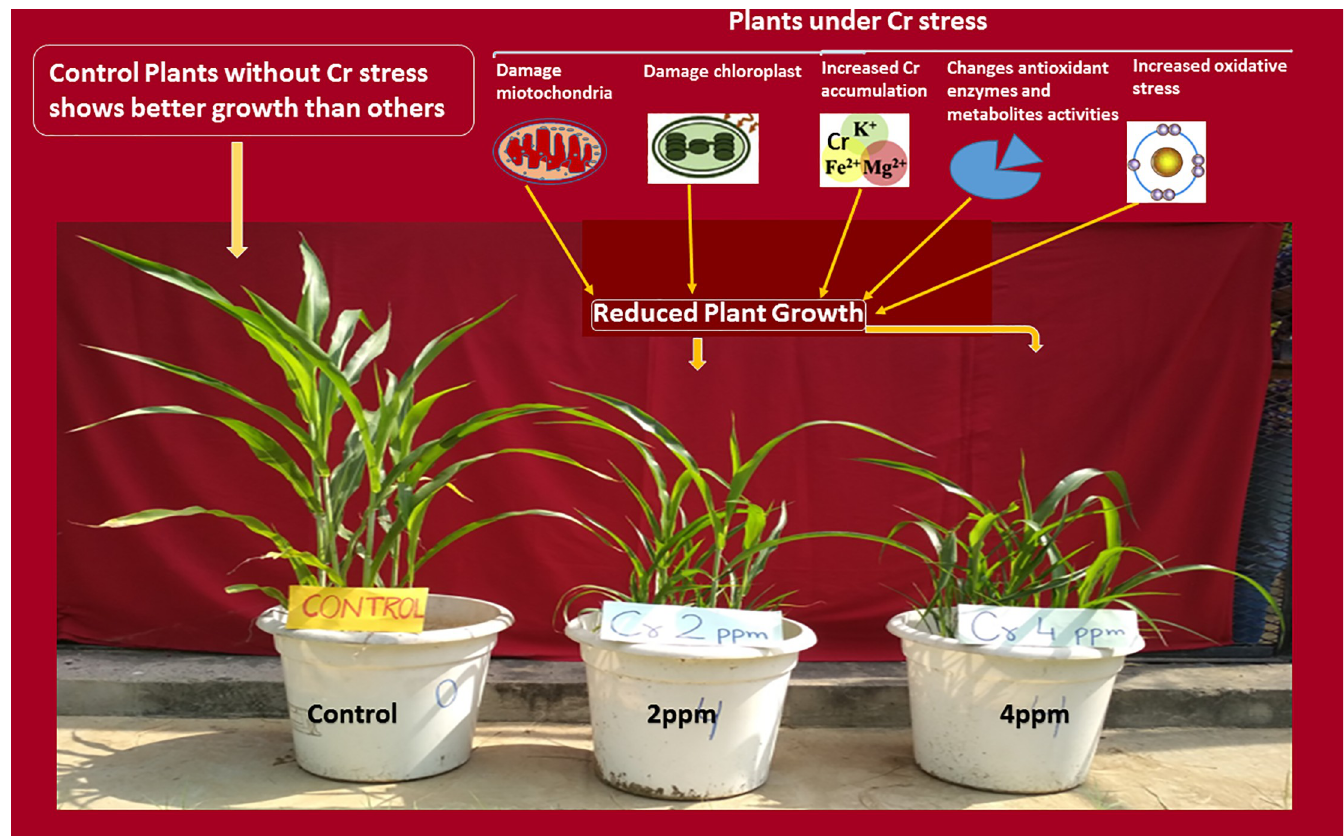
Fig 1. Morphological loss of growth in sorghum plants exposed with Cr toxicity as compared to control